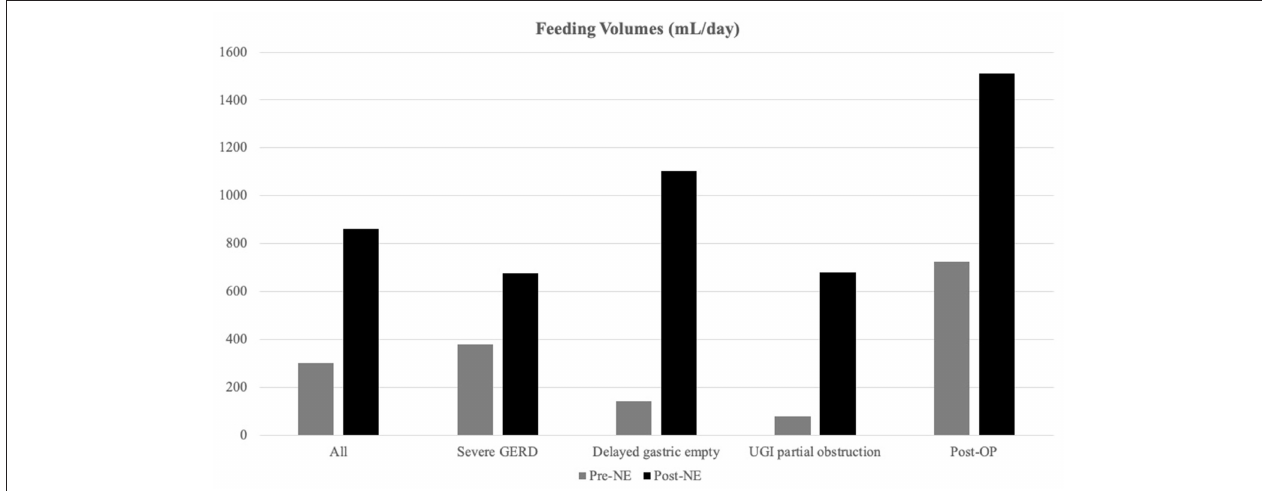
FIGURE 1 | Feeding volume alternations after nasoenteric (NE) tube feeding. Feeding volumes were increased significantly after NE tube placement, especially in the delayed gastric emptying group (from 144.8 ± 136.5 to 1,103.1 ± 524.7 ml/days) than the non-delayed gastric emptying group from 373.5 ± 389.4 to 755.9 ± 451.3 ml/days, p <